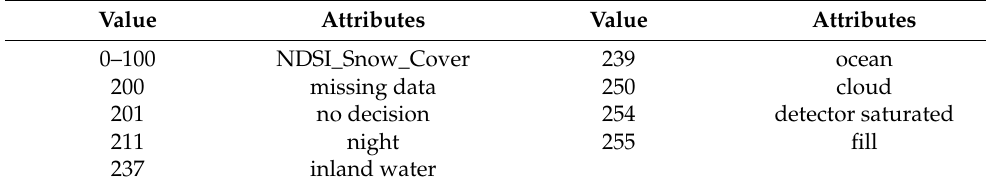
Table 1. MODIS Snow Products